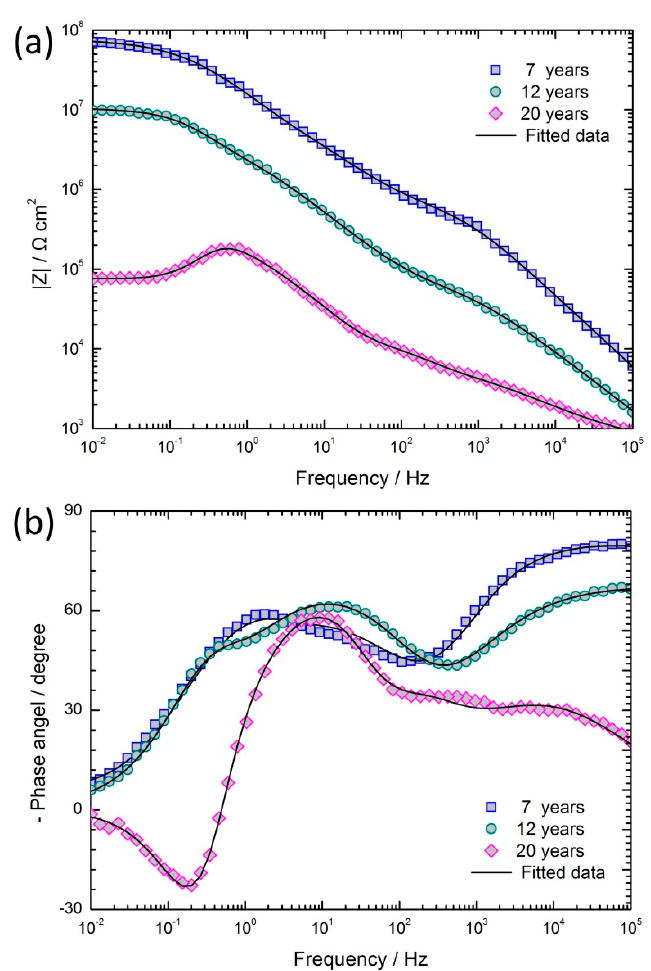
Figure 8. EIS results and its fitted data of coated specimens exposed for 7, 12, and 20 years: ( a ) Bode log |Z| versus log (f/Hz) plots; ( b ) Bode phase angle versus log (f/Hz) plots. The Bode log |Z| plots in Figure 8a are all described by lines with slopes between − 0.5 and − 0.2